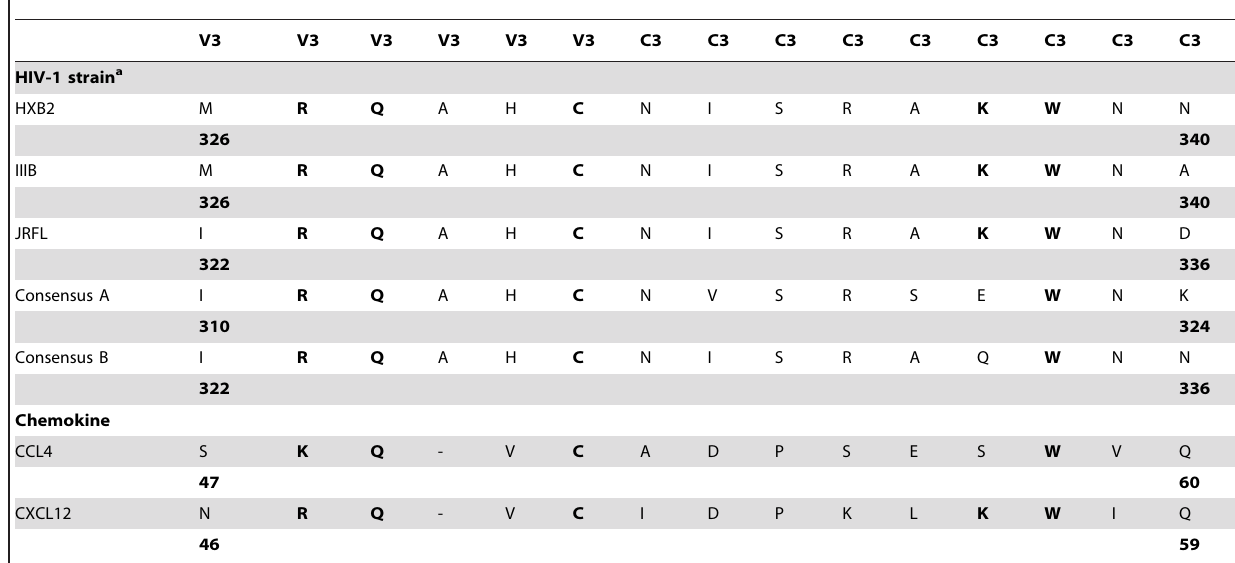
Table 1. Amino acid alignment of sequences of gp120 of some HIV-1 strains with CCL4 and CXCL12.